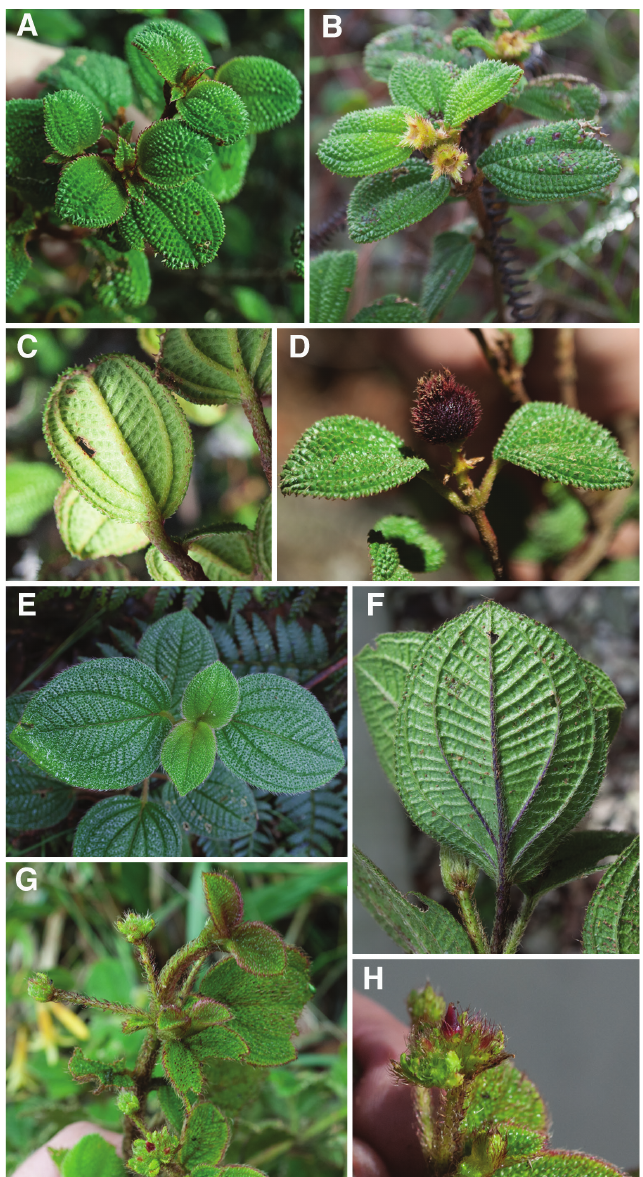
Figure 27. Photos of Miconia paralimoides ( A–D ) and M. pedunculata ( E–H ). A habit of M. par- alimoides showing well-developed bulla-based hairs on leaf adaxial surface B infructescence of M. par- alimoides C leaf abaxial surface showing obscured epidermis and ascending, appressed hairs on petioles D mature fruit of M. paralimoides (all from Majure 6021 ) E habit and adaxial leaf surface of M. pedun- culata F abaxial leaf surface showing dark purple primary and secondary veins G terminal, glomerulate inflorescence of M. pedunculata showing large bracts subtending floral buds and long, ascending hairs on inflorescence axis and stems H reddish-pink floral bud of M. pedunculata (all from Majure 6053 ). All photos taken by L.C.